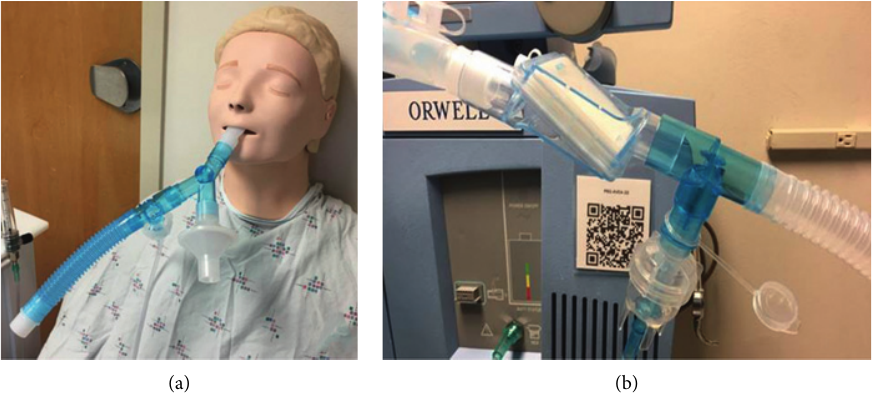
Figure 1: Demonstration of mechanism utilized for aerosolized dornase alfa administration: (a) AirLife ® Misty Max 10 TM Table 1: Characteristics of the patients, severity of the ARDS, number of doranase alfa treatments, and outcome in the treatment group. Characteristics